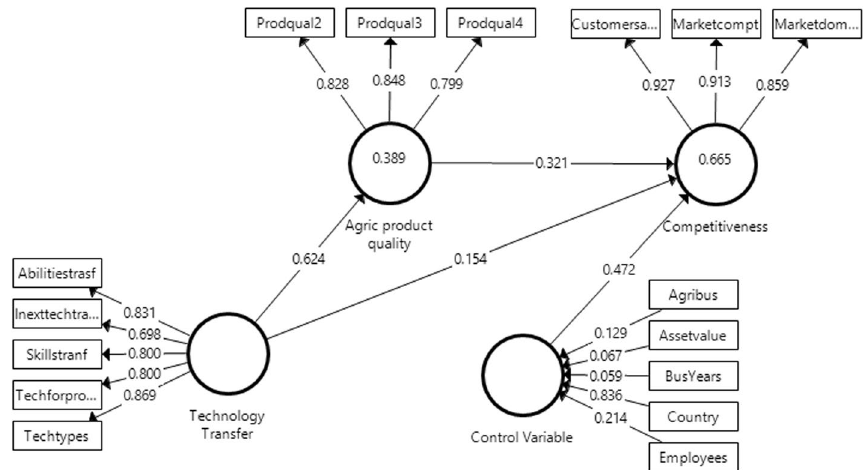
Fig. 2 The structural (path) relationships